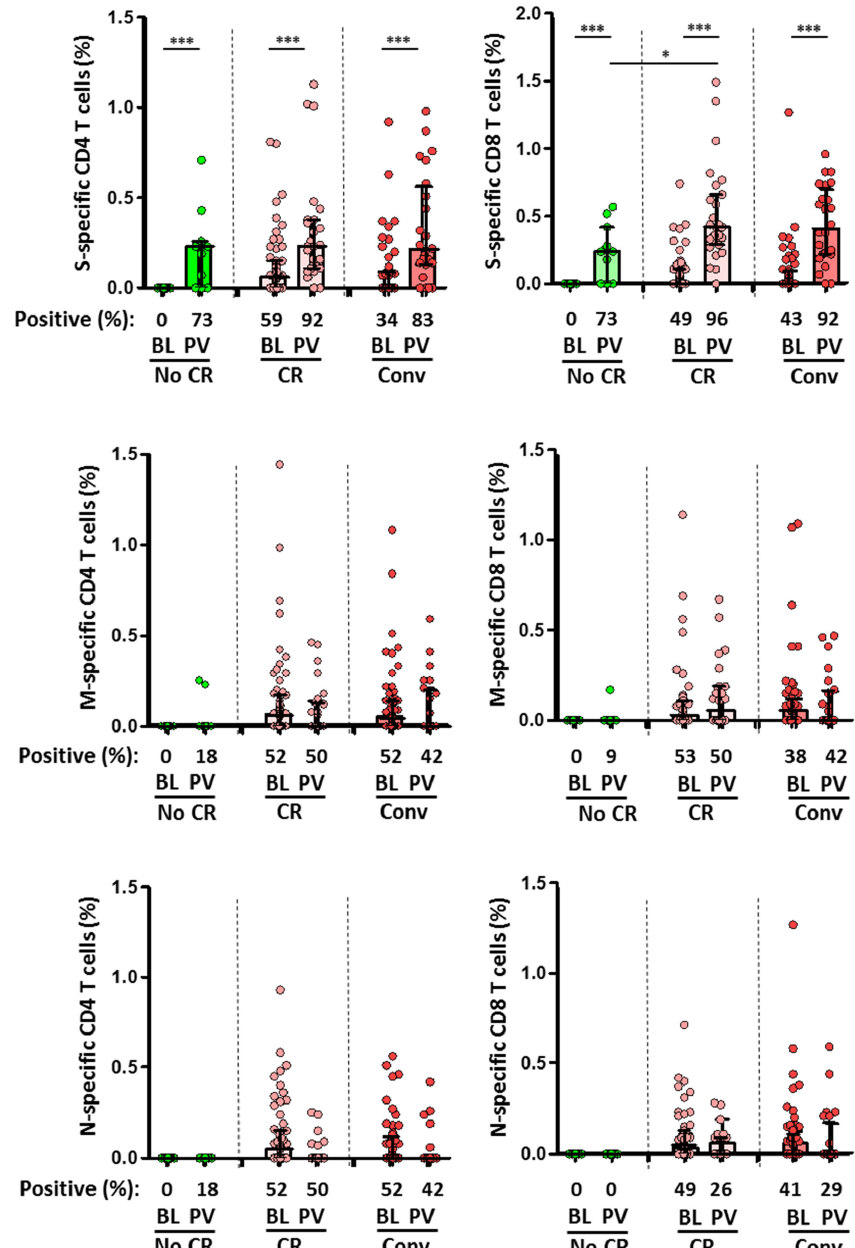
Figure 4. Comparison of the magnitude of CD4+ ( left ) and CD8+ ( right ) T-cell responses against SARS-CoV-2 S, M, and N proteins between the different subgroups at baseline (BL) and after two doses of vaccine (PV, post-vaccination). No CR (unexposed without cross-reactivity, green dots and bars), CR (unexposed with cross-reactivity, rose dots and bars), and Conv (convalescent, red dots and bars). Frequencies are indicated at the X axis. Statistically significant when p < 0.05. * = p < 0.05, and *** = p < 0.001.